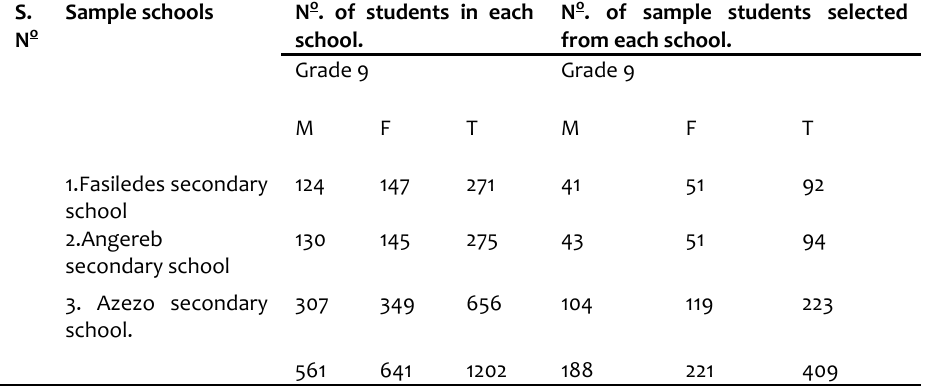
Table ‐ 1: Summary of sample schools, and number of students selected from each school.